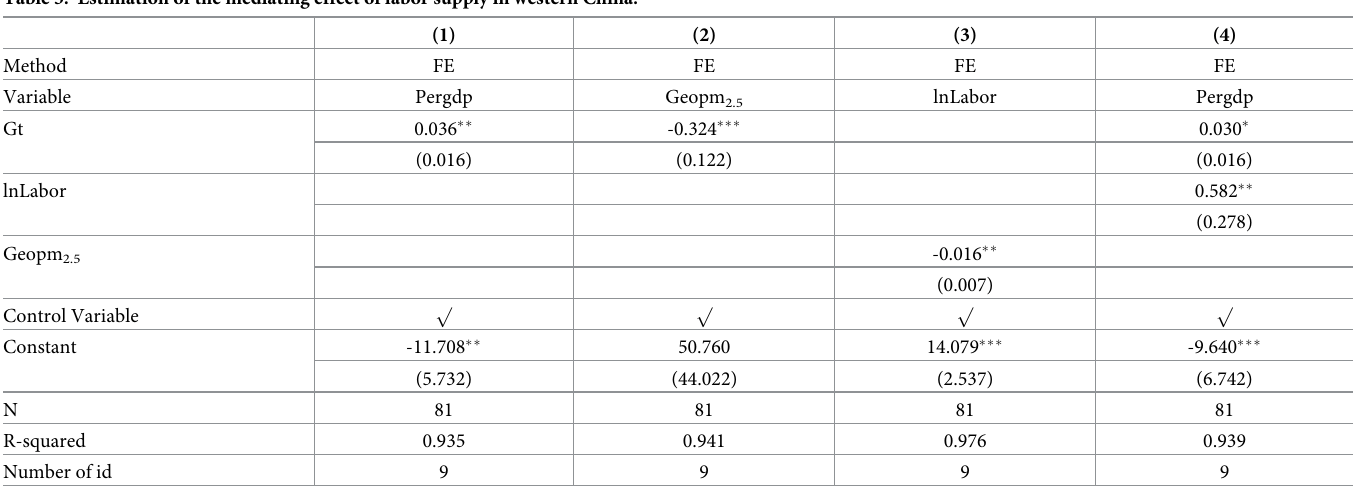
Table 5. Estimation of the mediating effect of labor supply in western